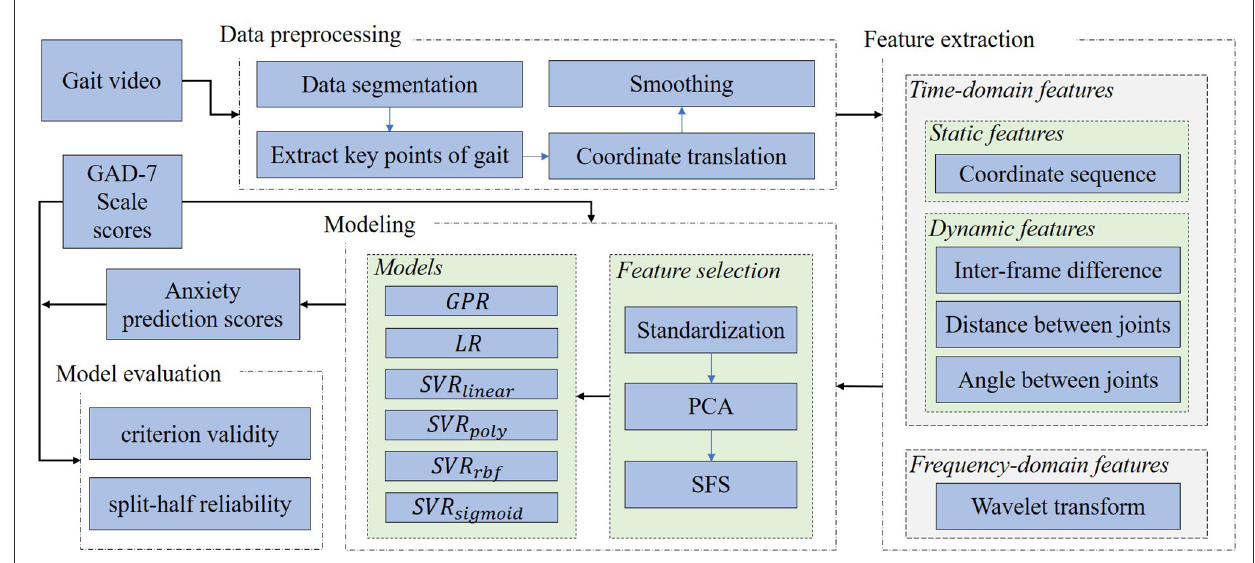
FIGURE5 Modeling process. PCA, principal component analysis; SFS, sequential forward selection; GPR, Gaussian process regression; LR, linear regression. SVR linear , SVR poly , SVR rbf , and SVR sigmoid represent support vector regression using linear, poly, rbf, and sigmoid kernel functions,